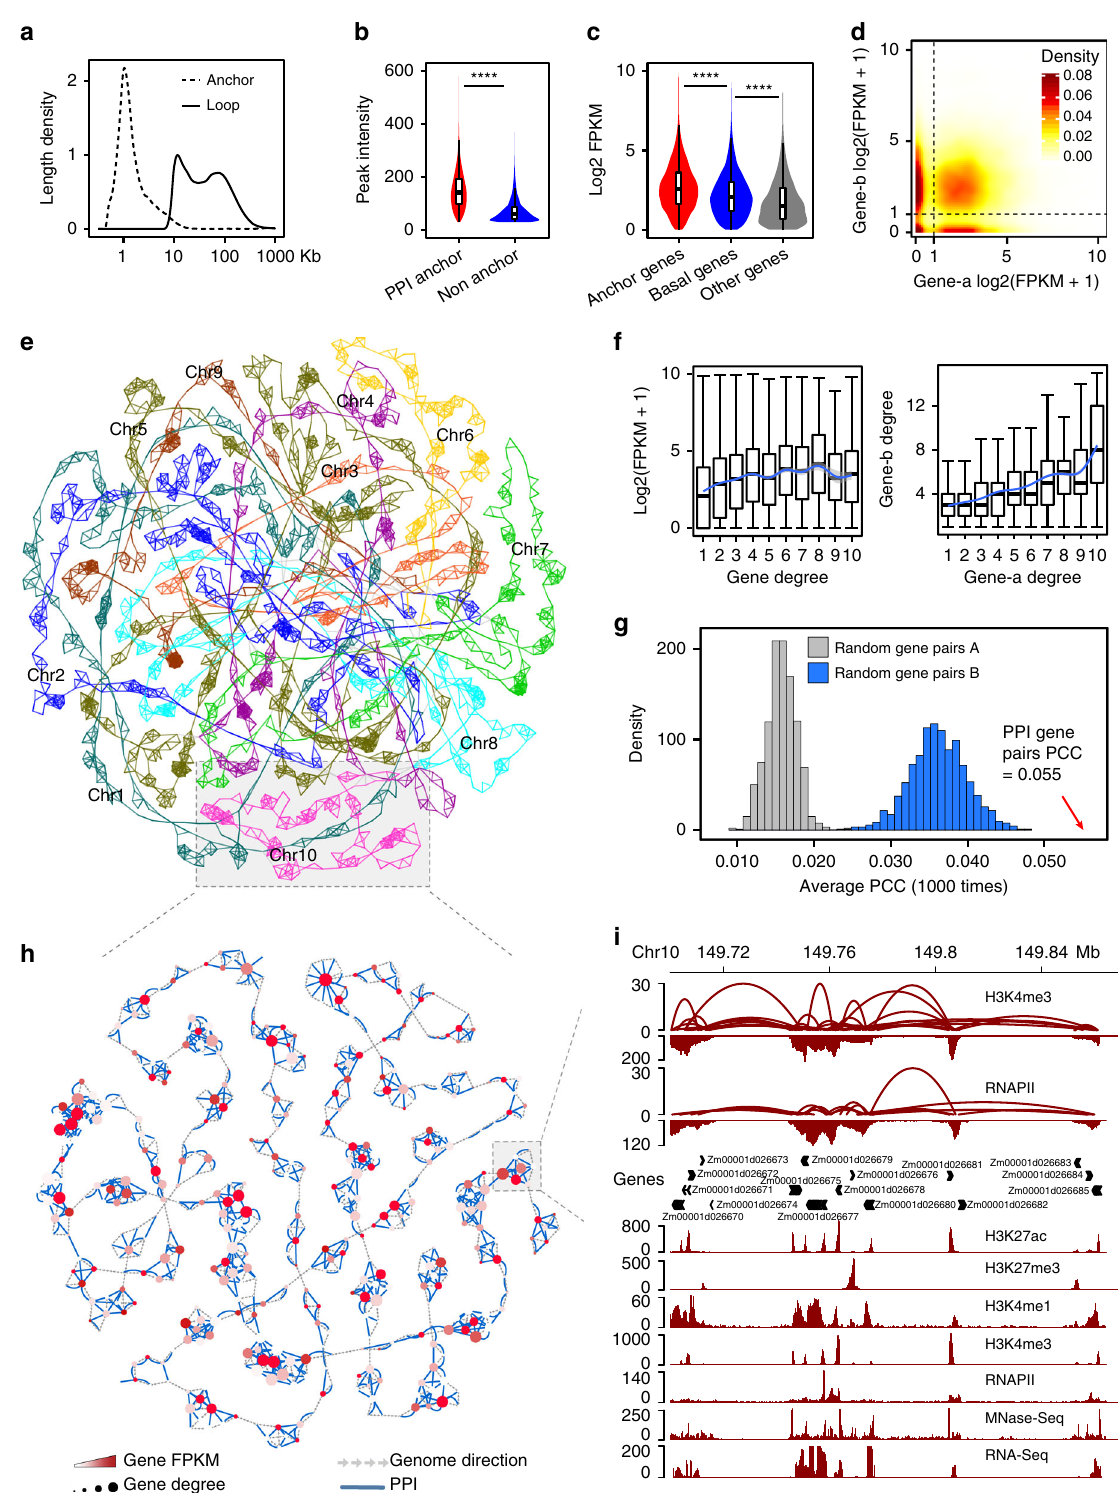
SNPs associated with expression traits (Fig. 4a). Within a 4-kb window centered on top SNPs in the testable eQTLs, we detected 405 eQTLs that were involved in chromatin interactions with